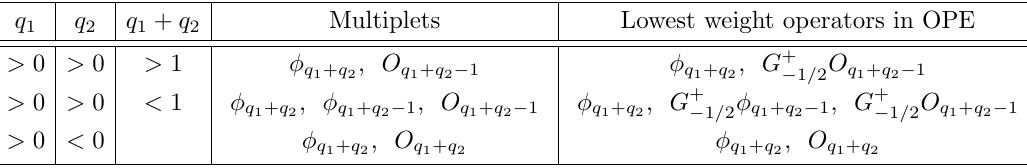
Table 1. = 2 selection rules for the OPE of a pair of BPS primaries (cid:30) q N q 1 and q 2